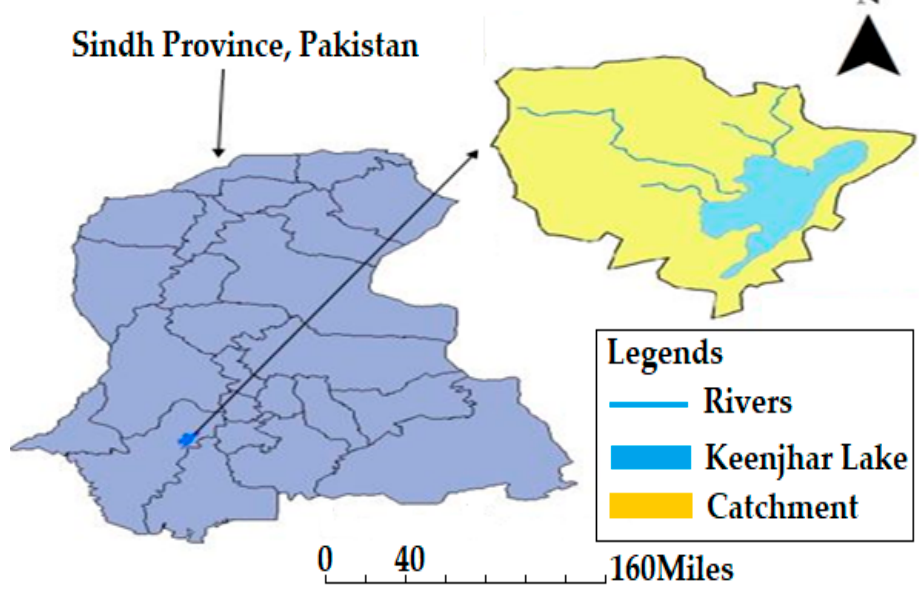
Figure 1. Description of study area.